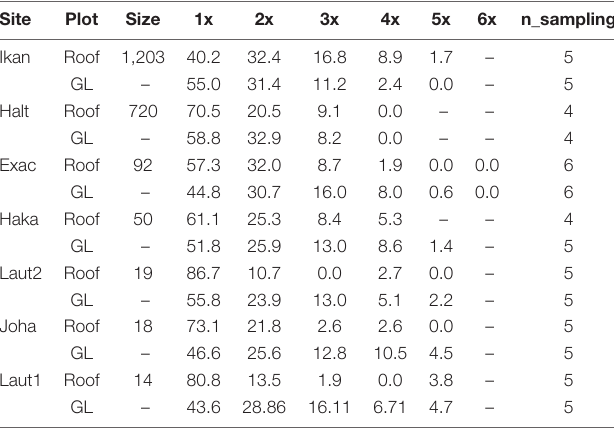
TABLE 2 | Proportion (%) of species collected from the same site and plot during one sampling occasion (1x), two sampling occasions (2x), ... , six occasions (6x, which is the maximum number of sampling